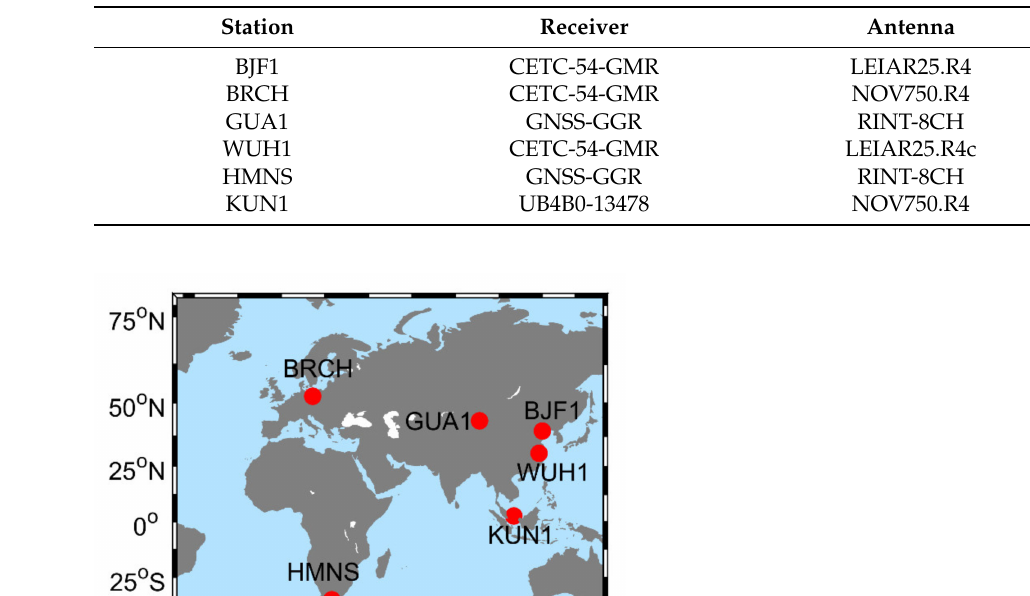
Table 3. Summaries the basic information of iGMAS stations.